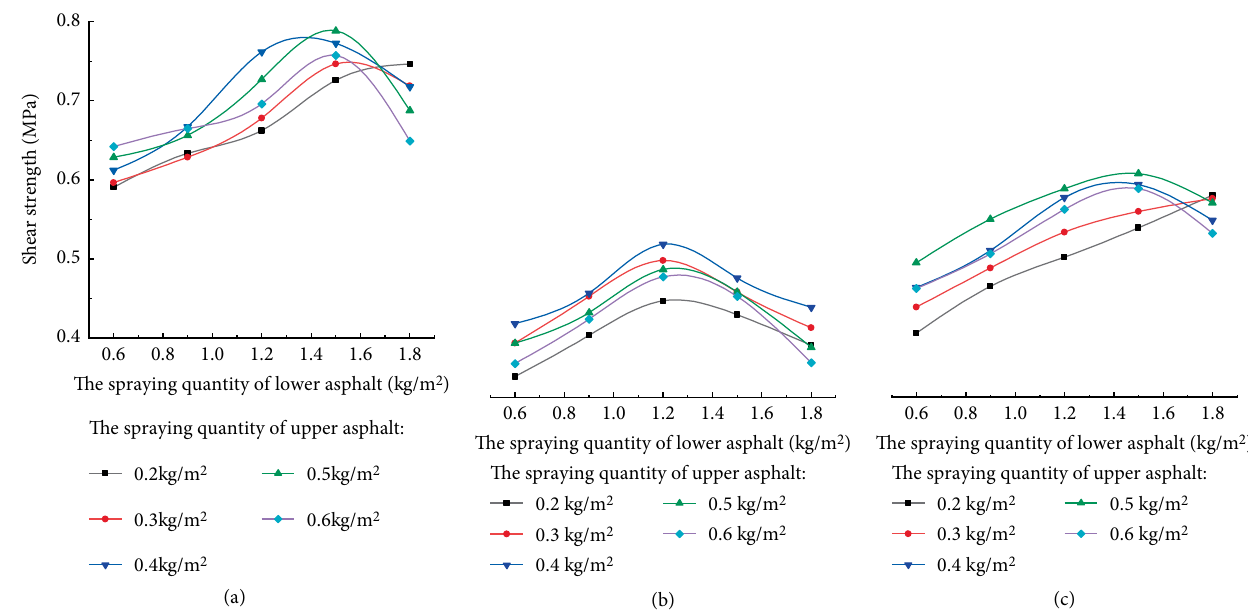
Figure 13: Shear strength of specimens with two oils and one aggregate interlayer treatment: (a) SBS-modified asphalt, (b) ordinary hot asphalt, (c) SBS-modified emulsified